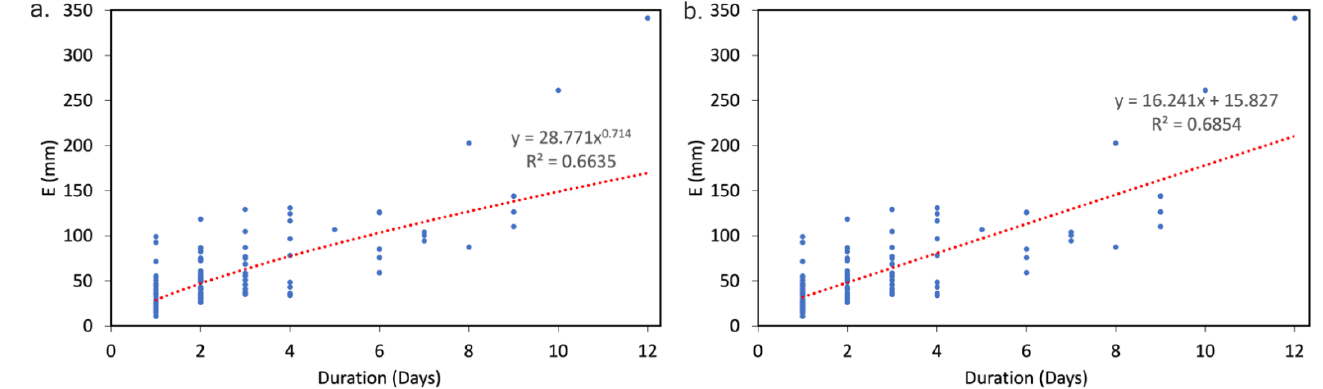
Figure 7. E-D threshold values for the training dataset with corresponding equations and determi- nation coefficients: ( a ) Equation (5a) — power form and ( b ) Equation (5b) — linear form. tion coefficients: ( a ) Equation (5a)—power form and ( b ) Equation (5b)—linear For each instance, the corresponding curve becomes as per Equations (9a) and (9b).